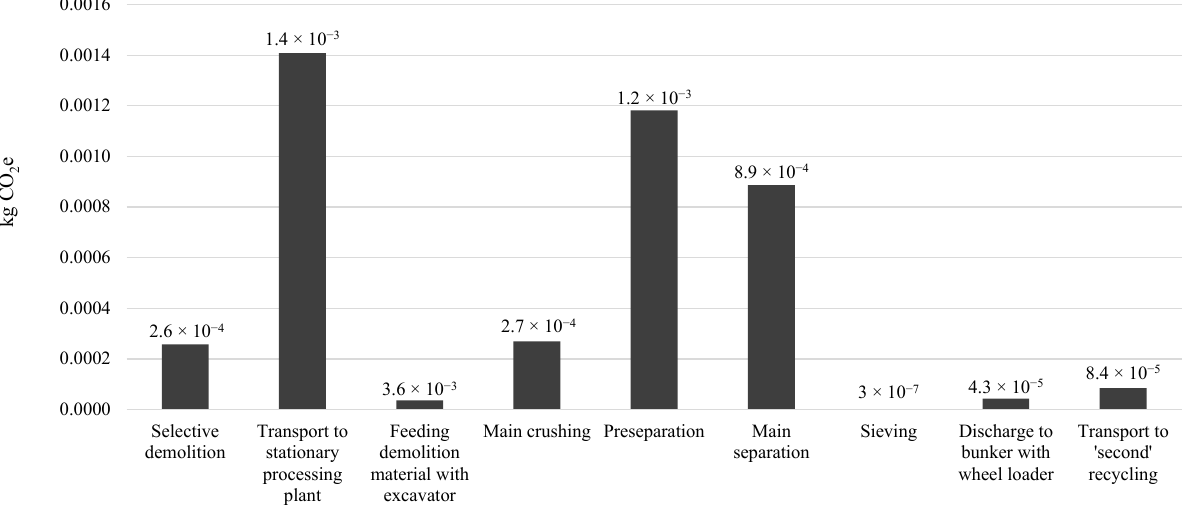
Figure 2. Global warming potential in kg CO 2 e of 1 kg re-usable material out of a double wall— recycling phase 1.